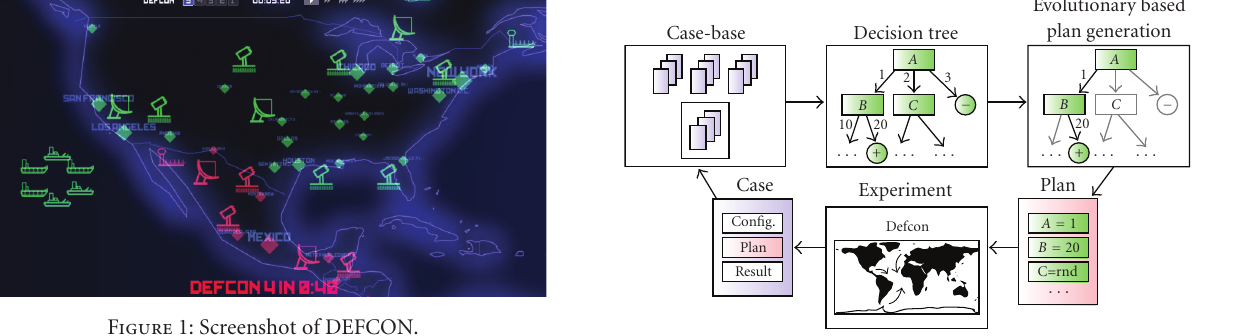
Figure 2: Overview of the system